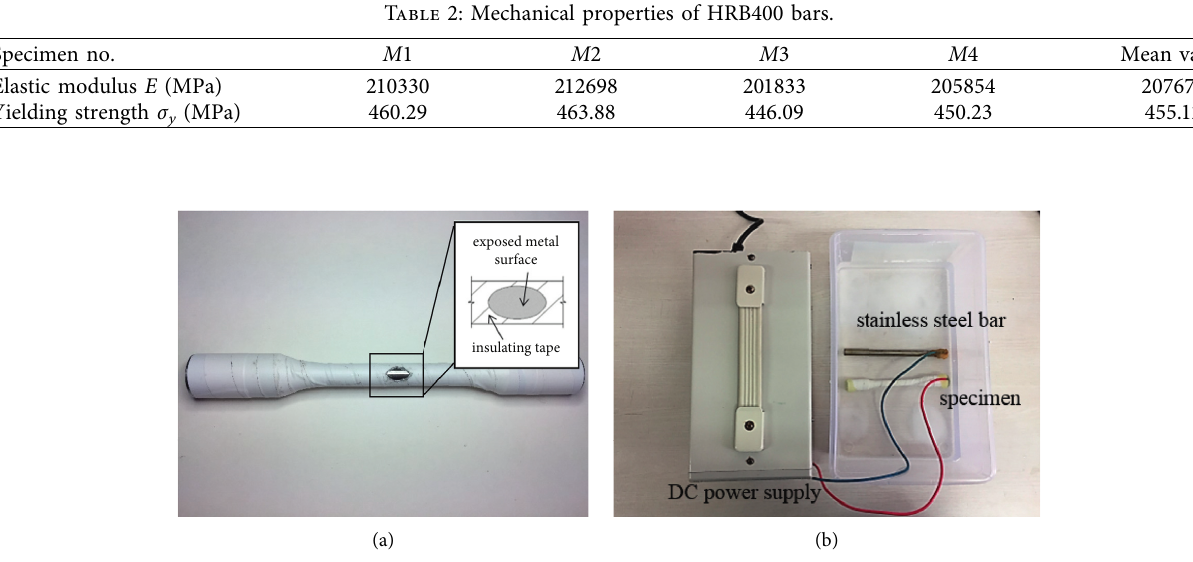
Figure 3: Treatment of specimen and precorrosion setup. (a) Treatment of specimen before corrosion process. (b) Corrosion environment